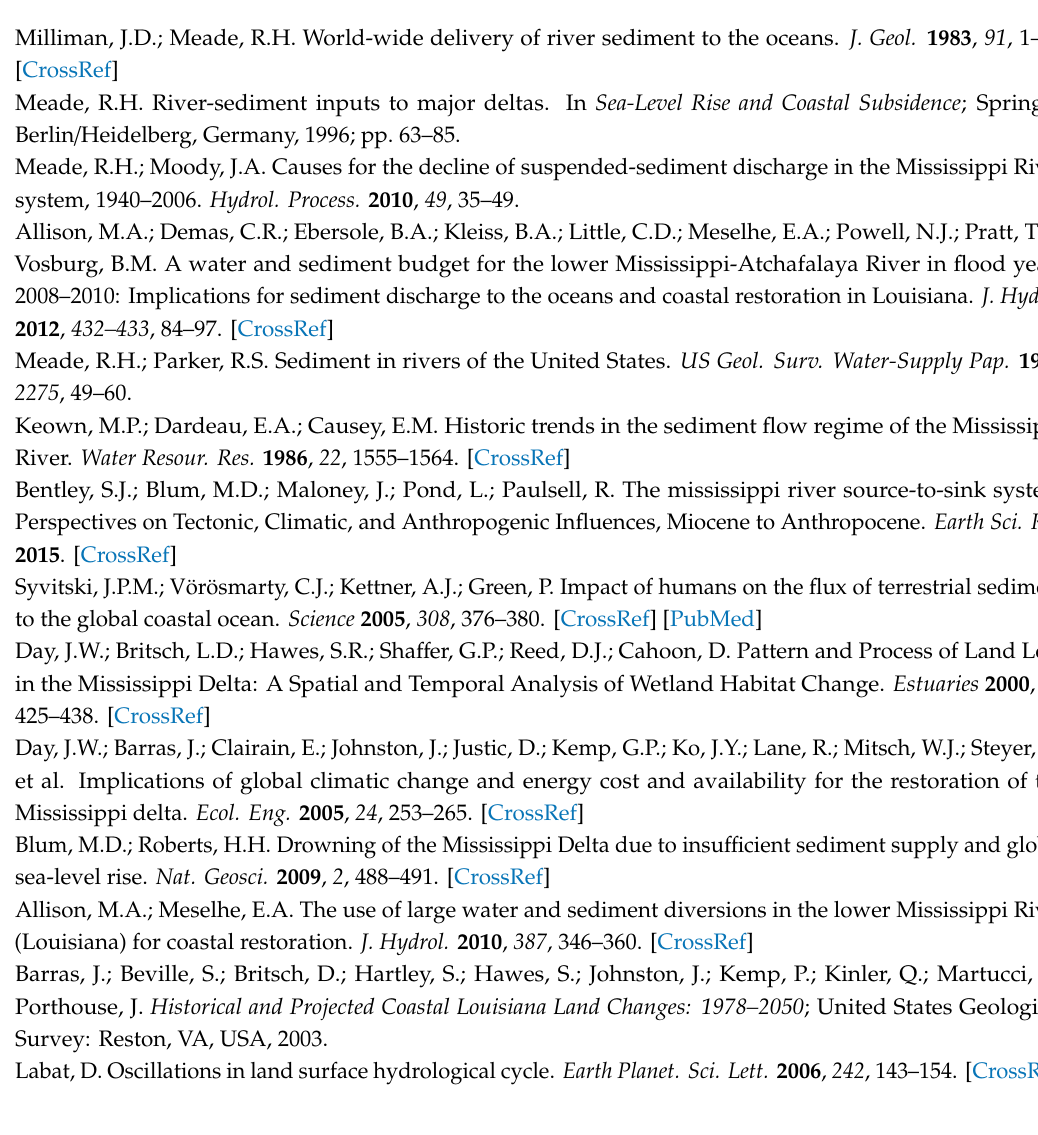
Figure S1: Mesh of the GoM domain (longitude: 98 ◦ W—79 ◦ W; latitude: 17.6 ◦ N—34.3 ◦ N; Horizontal Resolution: 5 km; Number of vertical layer: 36). Figure S2: Mesh of the nGoM domain (longitude: 94 ◦ W—87.6 ◦ W; latitude: 27.9 ◦ N—30.7 ◦ N; Horizontal Resolution: 1 km; Number of vertical layer: